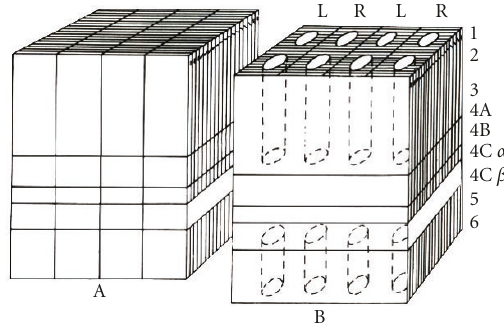
Figure 3: Ice cube model of the V1 area. The function and selec- tivity of cells remain more or less similar across the laminar layers and vary gradually along the surface. Cytochrome-oxidase staining reveals columns of colour sensitive cells in layer 2/3, obtained from